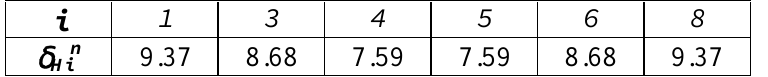
Table 2. Calculated substituent increments for proton NMR spectra of the one-ring substituted 2,7-naphthyridine derivatives,